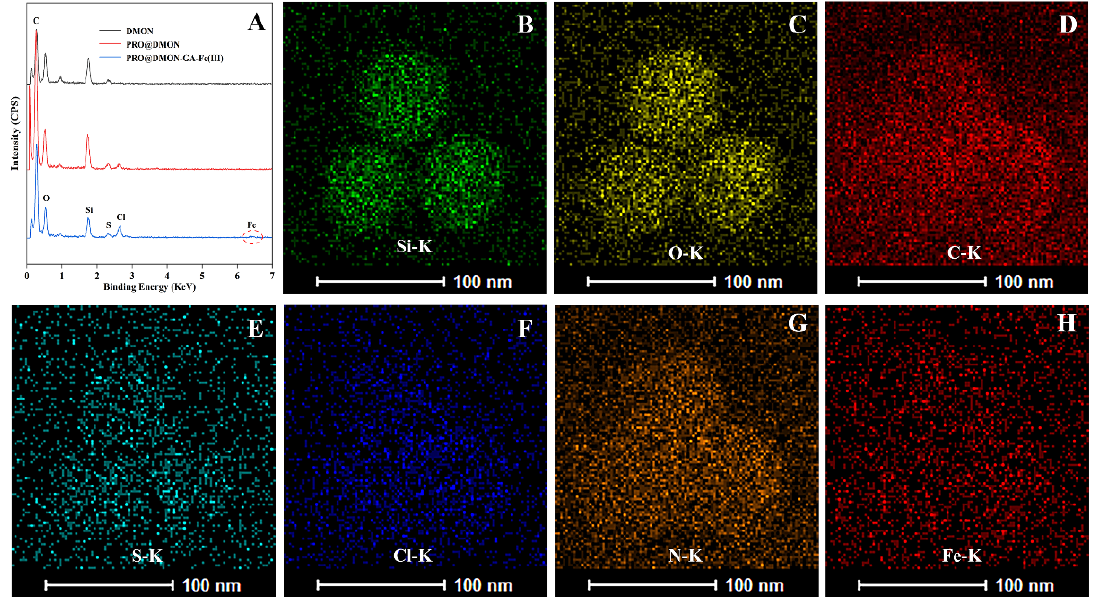
Figure 2. EDX spectra of DMON nanoparticles, PRO@DMON nanoparticles and PRO@DMON–GA–Fe(III) nanoparticles ( A ). TEM mapping of PRO@DMON–GA–Fe(III) nanoparticles ( B – H ).